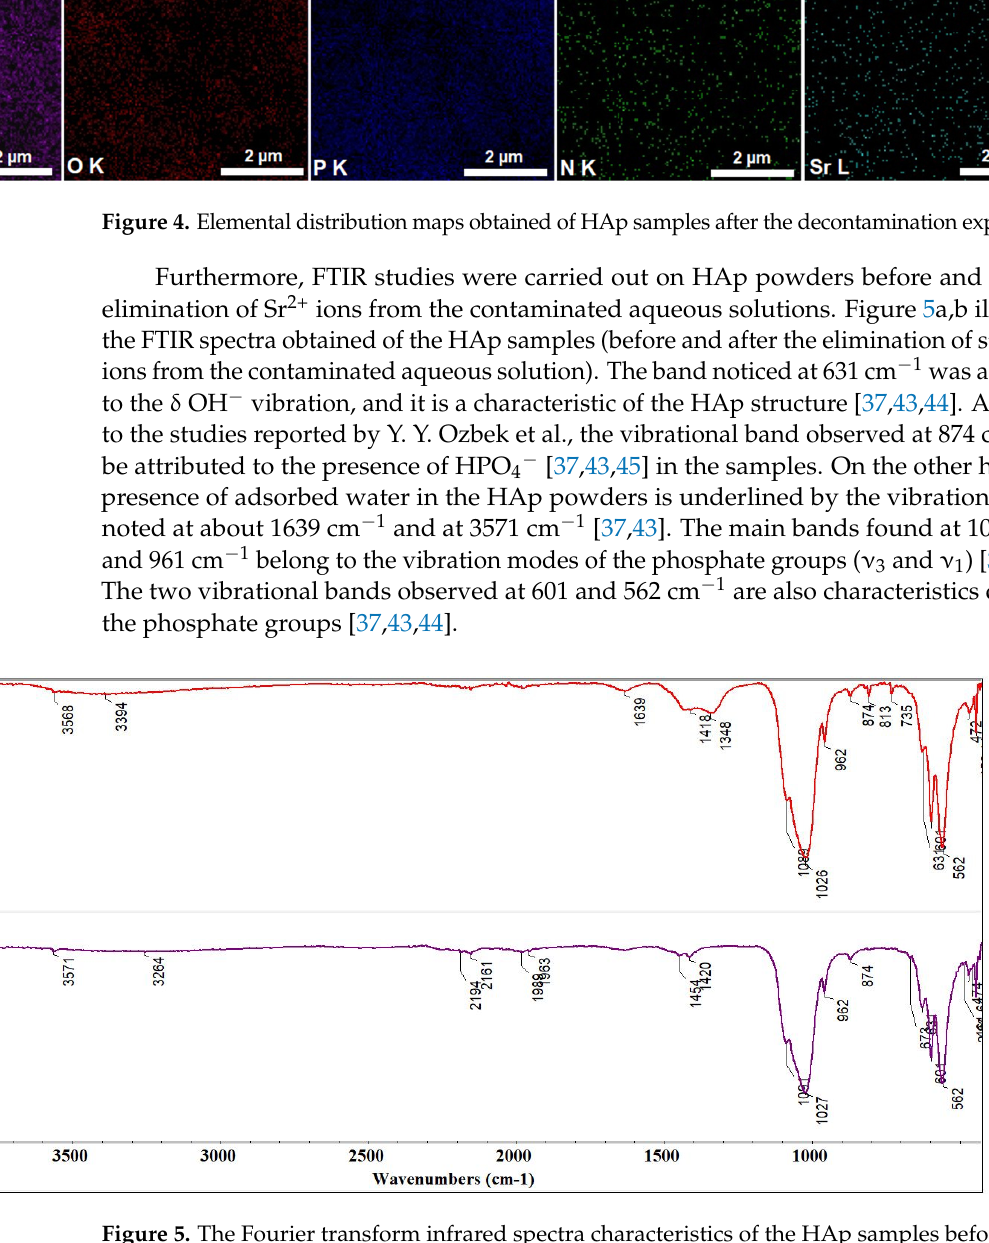
Figure 4. Elemental distribution maps obtained of HAp samples after the decontamination experi- ments.